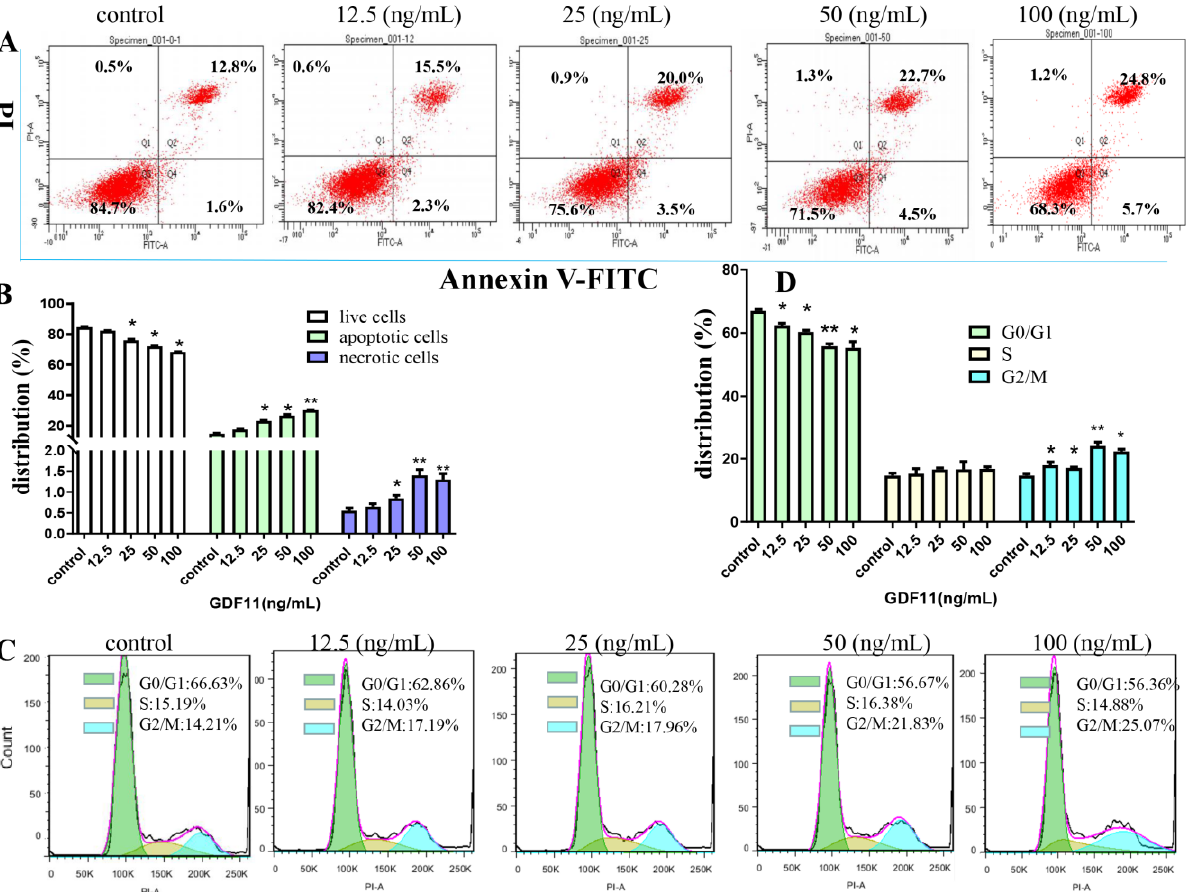
Figure 2. Effects of GDF11 on apoptosis and cell cycle of PC12 cells. ( A ) GDF11 promoted apoptosis in PC12 neural stem cells. PC12 cells were treated with various concentrations of GDF11 (0, 12.5, 25, 50, and 100 ng/mL) for 72 h, and then were assessed on a flow cytometry by using Annexin V − FITC and PI dual staining: Lower left quadrant; live cells (Annexin V − /PI − ); Lower right quadrant: early/primary apoptotic cells (Annexin V+/PI − ); Upper right quadrant: late/secondary apoptotic cells (Annexin V+/PI+); Upper left quadrant: necrotic cells (Annexin V − /PI+). ( B ) Quantitative analyses of apoptosis as in ( A ). ( C ) GDF11 induced cell cycle arrest at G2/M phase. PC12 cells were incubated with GDF11 (0, 12.5, 25, 50 and 100 ng/mL) or vehicle for 72 h and analyzed by Flow cytometry. ( D ) Histogram of cell cycle distribution as in ( C ). * p < 0.05, ** p <